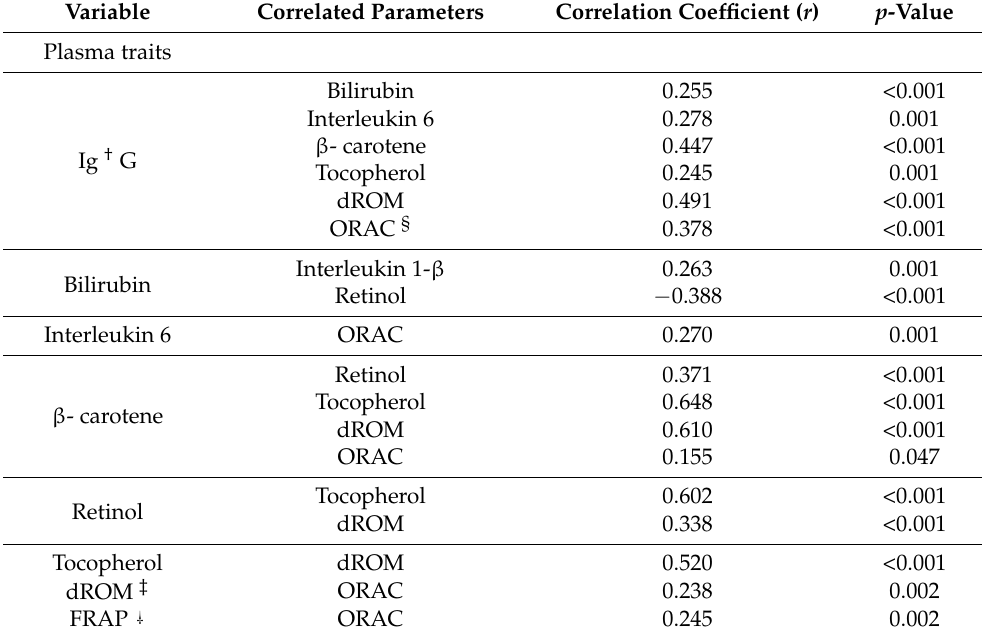
Table 1. Experimental design and animals.